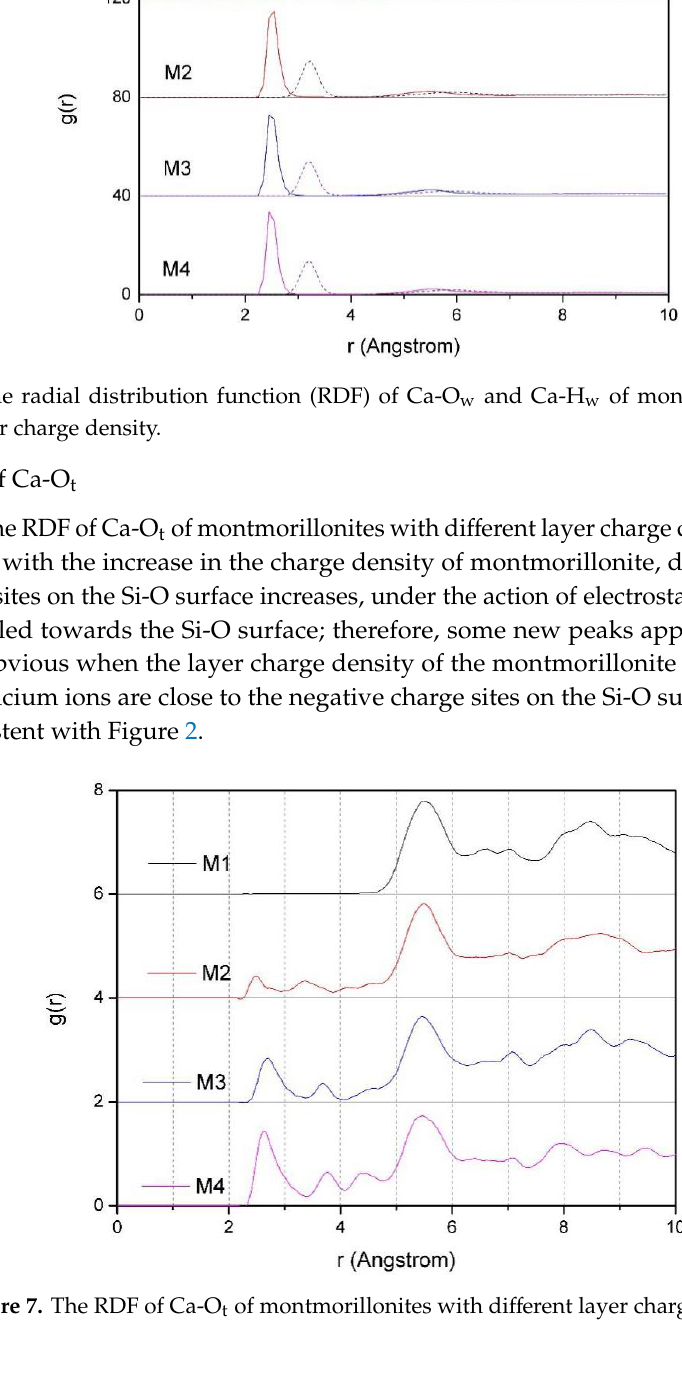
ff erent layer charge